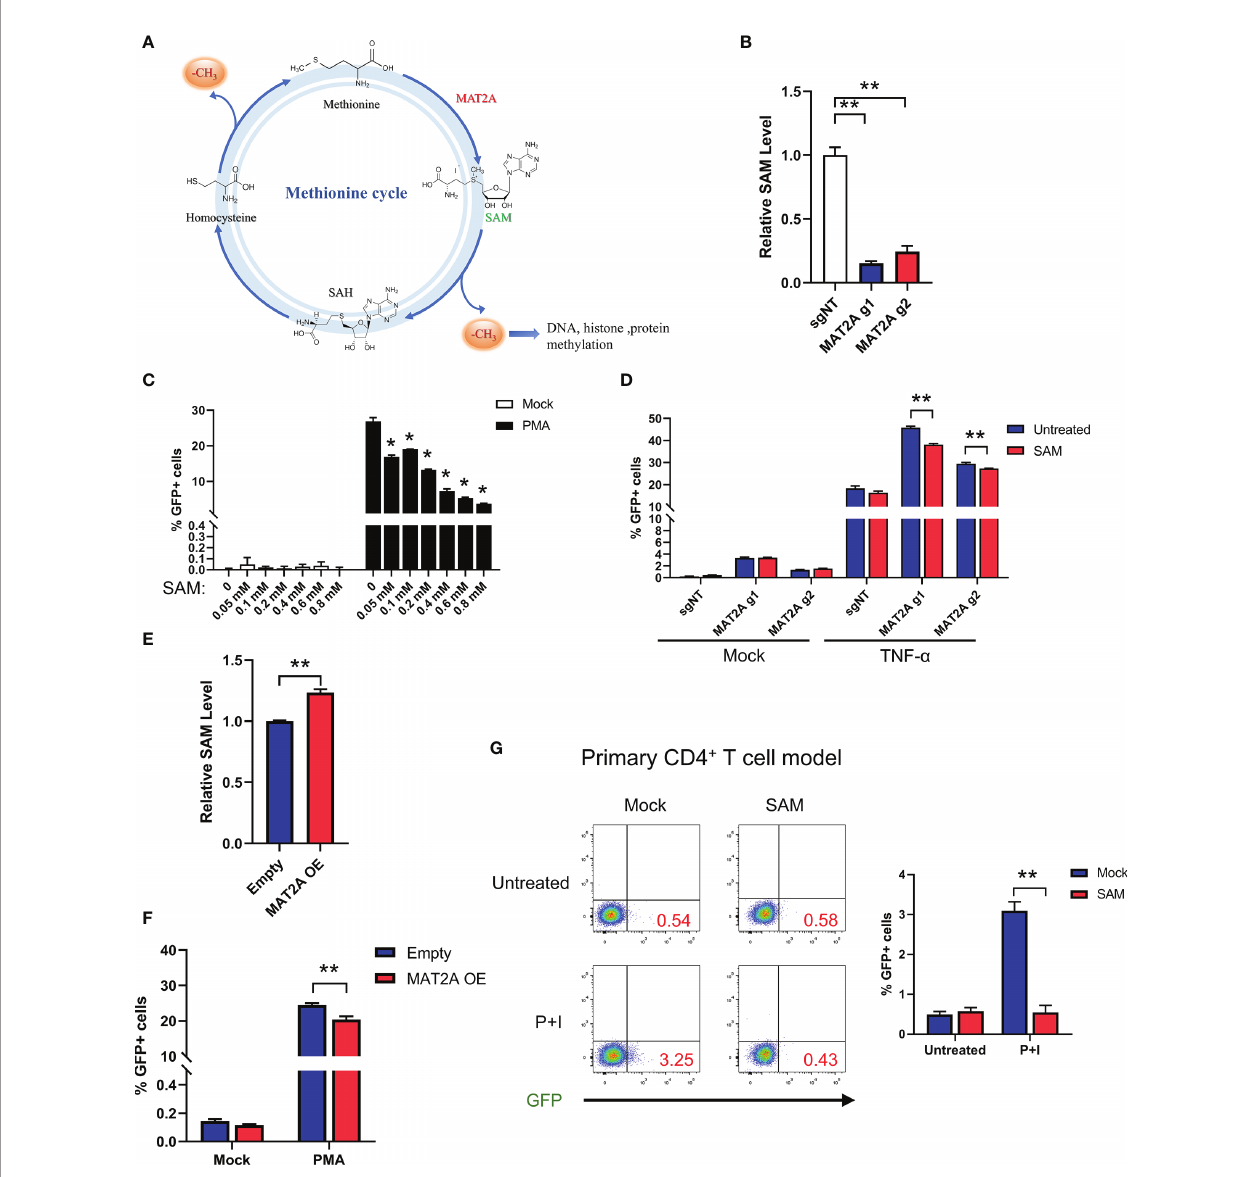
FIGURE 4 | MAT2A regulates HIV-1 latency through SAM-Mediated One-Carbon Flux. (A) Overview of the methionine cycles. (B) LC-MS analysis of intracellular SAM in J-Lat 9.2 cells with or without MAT2A knockout. (C) J-Lat 9.2 cells were treated with different doses of SAM and then stimulated with or without PMA. GFP-positive cells were measured by fl ow cytometry. (D) J-Lat 9.2 cells with or without MAT2A knockout were treated with SAM for 2 days and stimulated with PMA for 24 h GFP-positive cells were measured by fl ow cytometry. (E) LC-MS analysis of intracellular SAM of J-Lat 9.2 cells with MAT2A overexpression. (F) Flow cytometry analysis of GFP positive cells in MAT2A overexpressed J-Lat cell lines with or without PMA stimulation. (G) BCL-2 cell model treated with or without SAM (0.8 mM) for 2 days and stimulated with PMA and ionomycin for 24 h Reactivation ef fi cacy of latent HIV-1 was assessed by measured GFP by fl ow cytometry. Data were presented as mean ± SD from three independent experiments (Student ’ s t-test, *p < 0.05, **p <